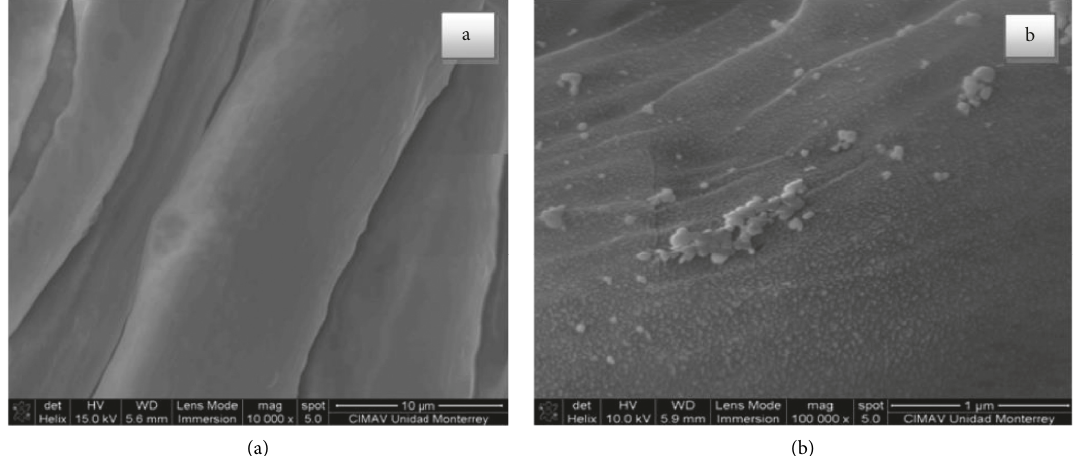
Figure 5: Scanning electron microscopy (SEM) image of (a) cotton and (b) cotton/AgNP composite (adapted with permission from ref. [40]).